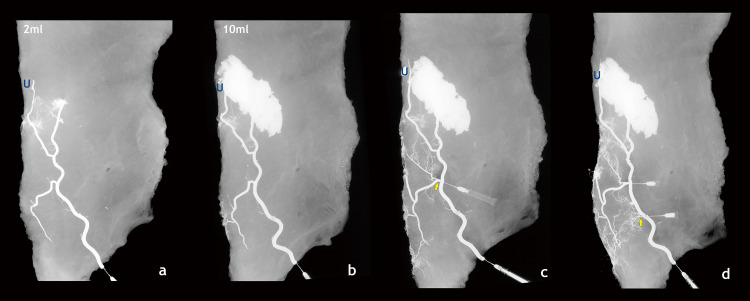
Venograms of the serial injections.(a, b) The left two venograms show serial injections (2 mL, 10 mL) through the caudal end of the superficial inferior epigastric vein. Only a part of the medial branches of the superficial inferior epigastric vein was visible despite sufficient injection. (c, d) After cannulation and injection of the medial branches of the SIEV (yellow arrow), the venous anatomy of the infraumbilical midline area was visualized, showing the fine polygonal venous network.